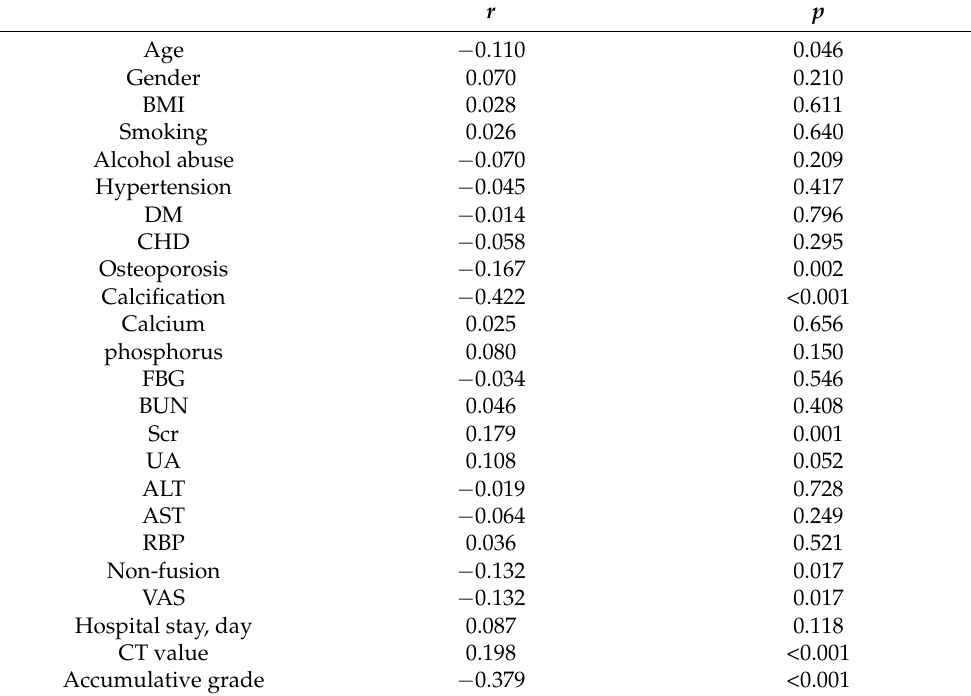
Table 4. Correlation of AAPR with demographic and clinical parameters.